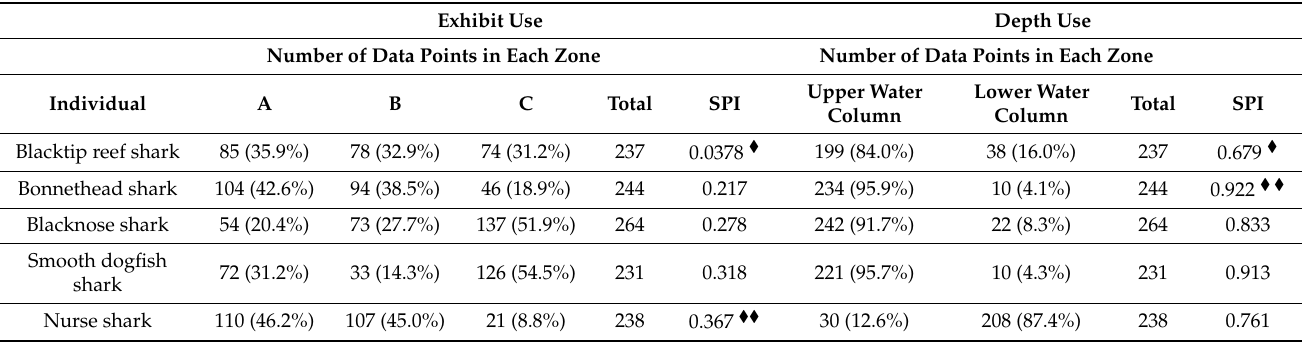
Table 1. Total number of data points in each zone and calculated SPI values for all five focal individuals. The ‘Exhibit Use’ section compares evenness for the front, back, and perimeter zones (i.e., XY-axis), whereas the ‘Depth Use’ section compares evenness for the upper and lower water columns (i.e., Z-axis). The (cid:7) symbol indicates the species with the most even space use, whereas the (cid:7)(cid:7) symbol indicates the species with the most uneven space use. Exhibit Use Depth Use Number of Data Points in Each